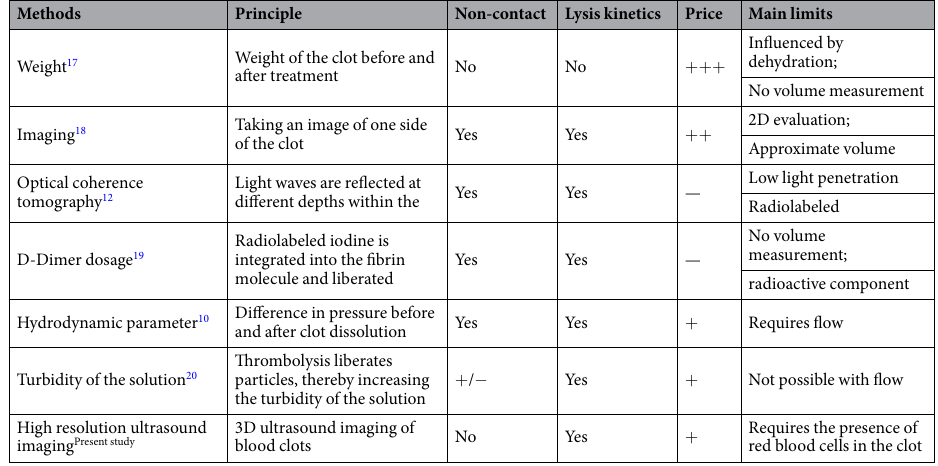
Table 1. The main methods used to measure clot dissolution during in vitro